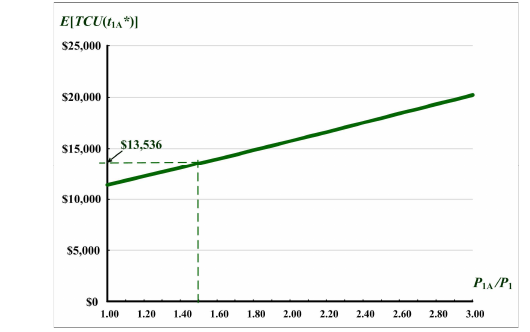
Fig. 10 . Analytical results on cost elements in Fig. 11. The impact of changes in expedited ratio P 1A / P 1